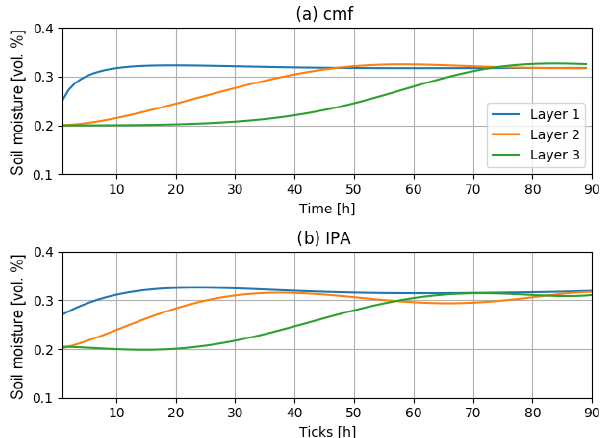
Figure 3. Comparison of soil moisture development of the upmost three layers with a homogenous soil in the